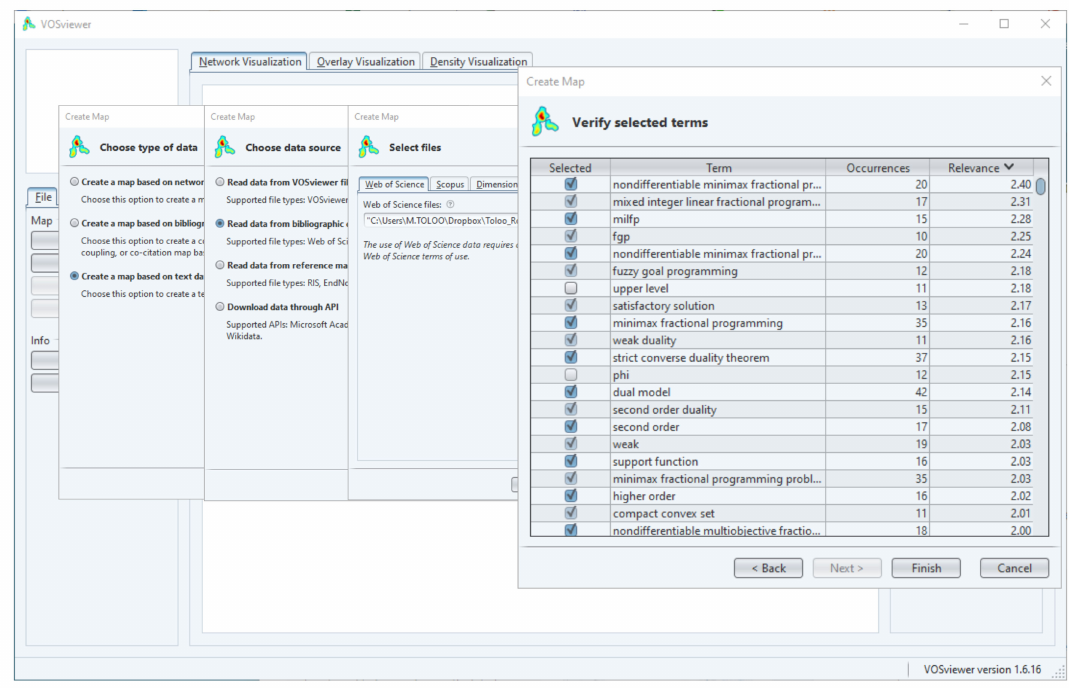
Figure 3. VOSviewer analysis